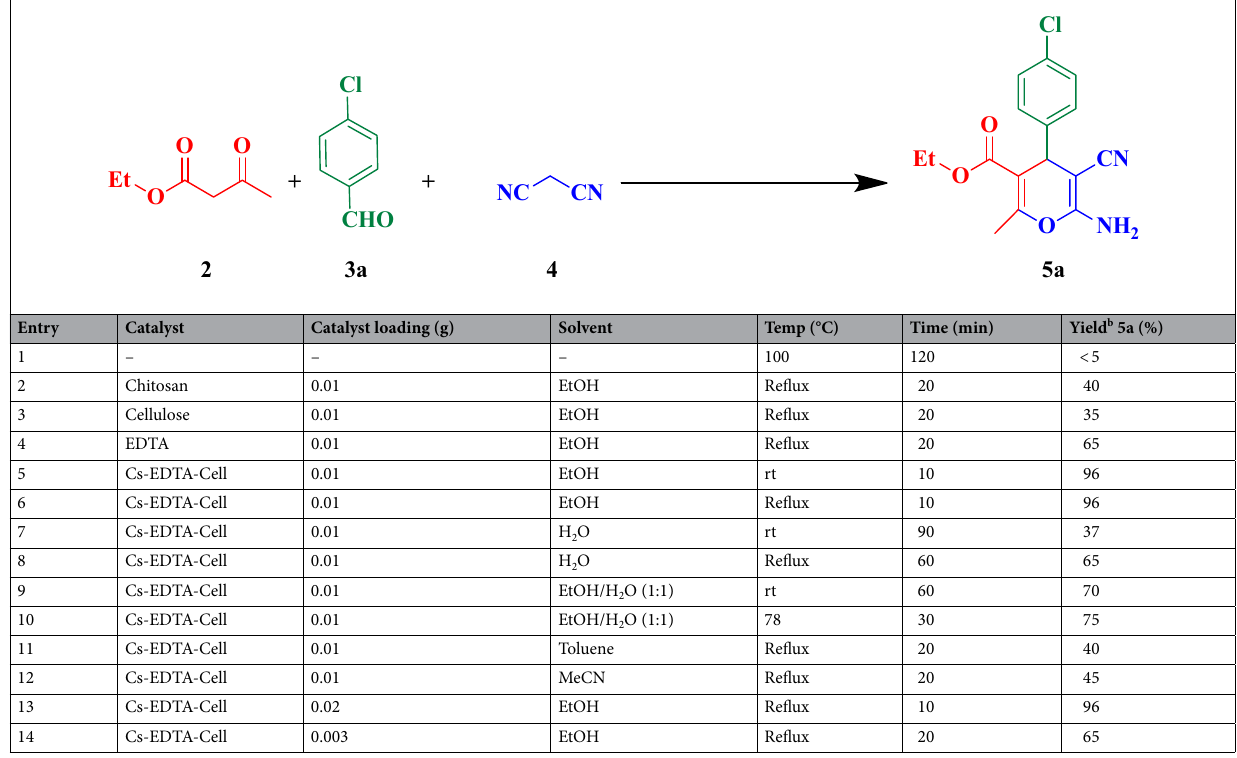
Table 1. Optimizing of different parameters for the model reaction in the synthesis of 5a catalyzed by Cs-EDTA-Cell network ( 1 ) a . a Reaction conditions: ethyl acetoacetate ( 2 , 1.0 mmol), aldehyde ( 3a , 1.0 mmol) and malononirile ( 4 , 1.0 mmol) in the presence of Cs-EDTA-Cell network ( 1 ) was added to the solvent (3.0 ml) unless otherwise stated. b Isolated